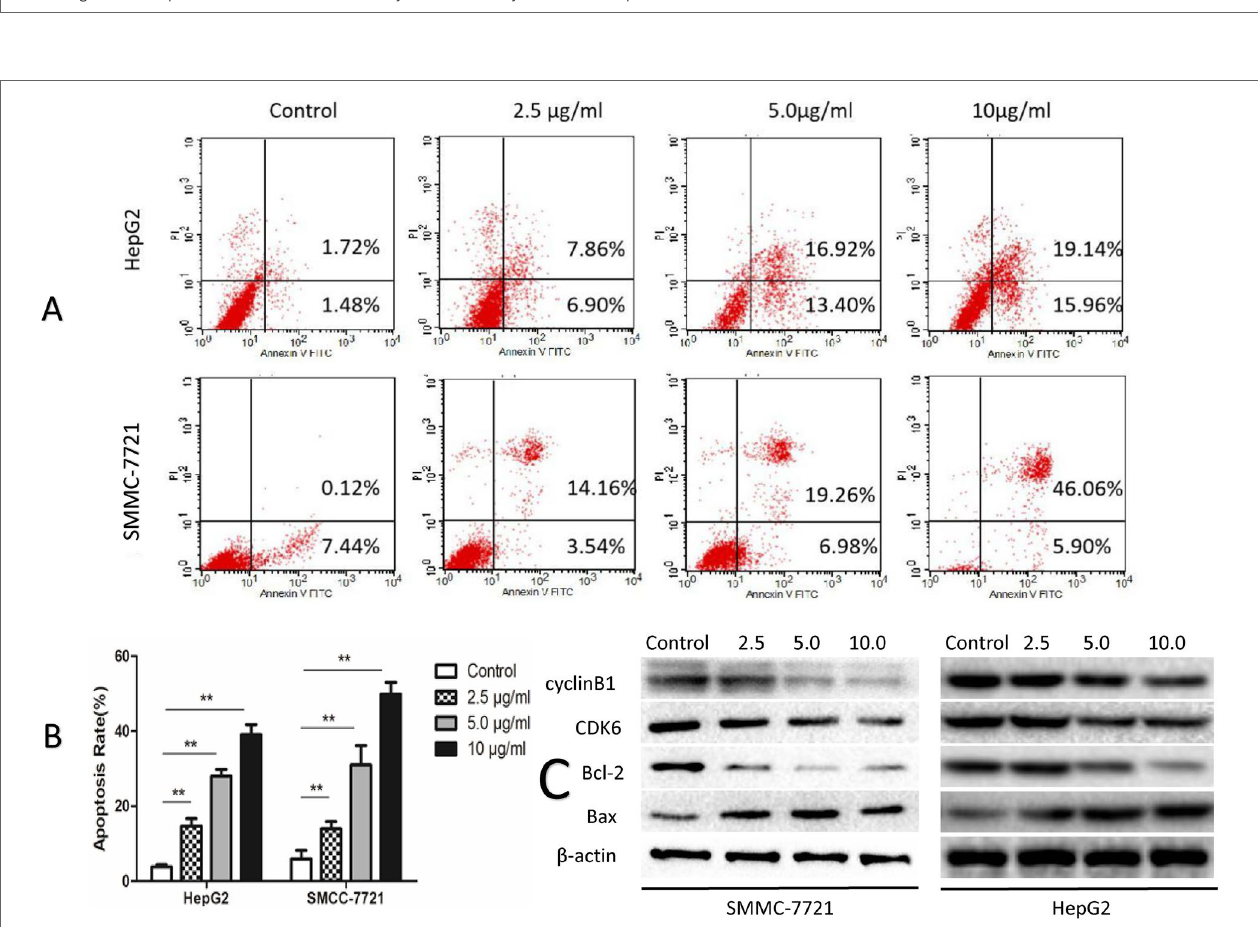
FIGURE 2 | SSd increased apoptosis in SMMC-7721 and HepG2 cells. (A) The tumor cells were treated with SSd at various concentrations or vehicle (control) and analyzed by flow cytometric analysis. (B) Apoptosis rates in all treatment groups are presented as a histogram (data were expressed as mean ± SD). (C) Western blots of Bax (a pro-apoptotic protein), CDK6, Bcl-2, and cyclin B1. β -Actin was used as a loading control